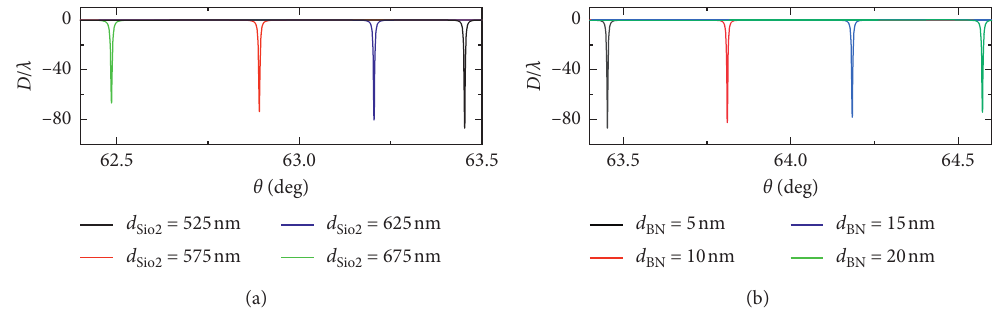
Figure 5: The variation of the GH shift with the incident angle at different thicknesses, while (a) changing the thickness of SiO � 5nm) and (b) changing the thickness of BN ( d ( d BN